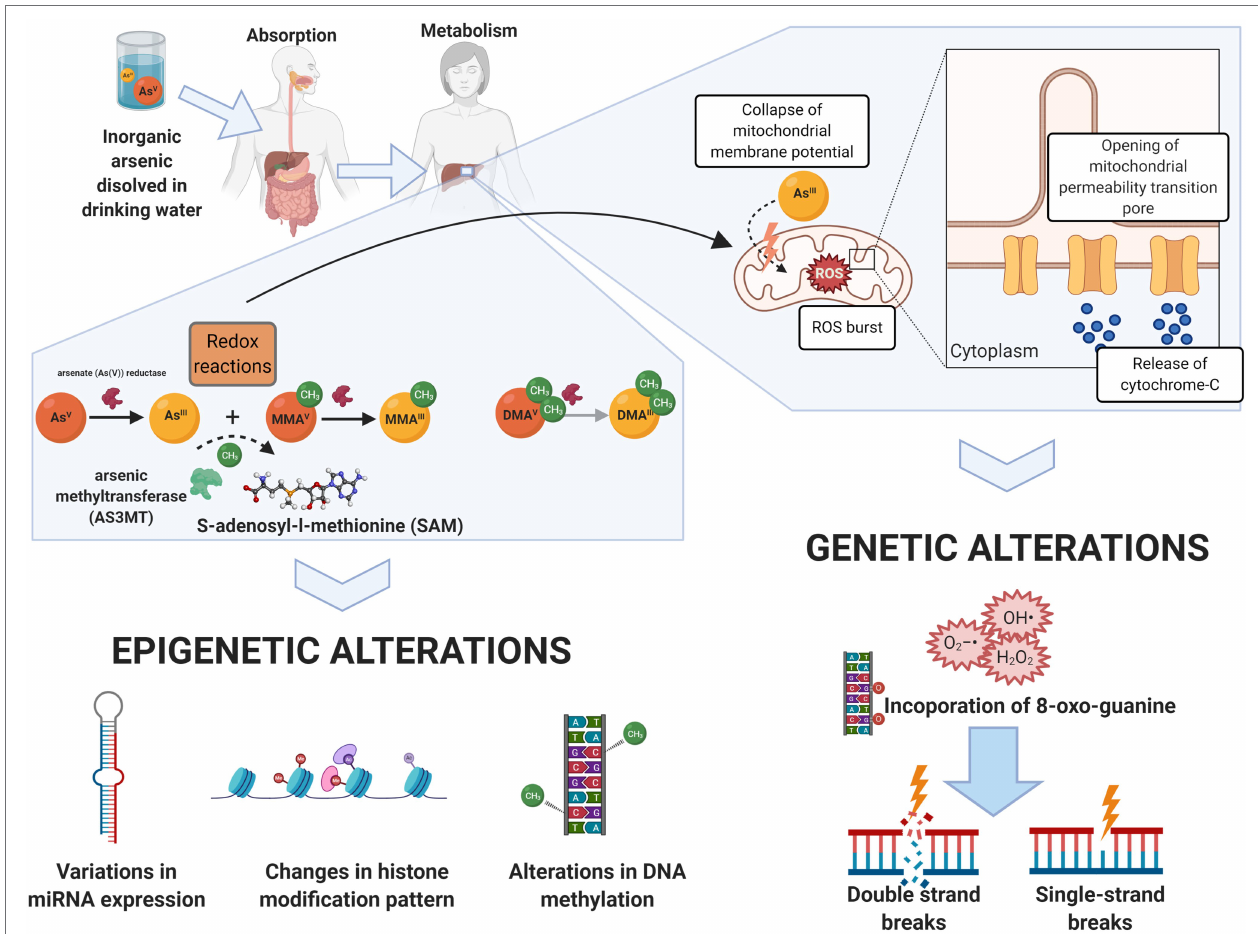
FIGURE 2 | Arsenic biotransformation as mechanisms for molecular damage. Arsenic dissolved in drinking water (mainly as arsenate, in its oxidation state +5, As[V]) is readily absorbed by the gastrointestinal tract. Biotransformation of arsenic occurs in the liver, where arsenite (As[III]) and As[V] goes through a series of redox reactions, resulting in the generation of mono and dimethylated arsenic intermediaries: Monomethylarsonous acid (MMA[III]), monomethylarsonic acid (MMA[V]), dimethylarsinous acid (DMA[III]), and dimethylarsinic acid (DMA[V]). S-adenosylmethionine (SAM) is the methyl donor during arsenic biotransformation to both oxidation state III and oxidation state V arsenic species. The transfer of a methyl group from SAM to trivalent arsenicals is catalyzed by the arsenic6 (+3 oxidation state) methyltransferase (AS3MT), producing methylated and dimethylated arsenicals. Epigenetic alterations, including global and local DNA methylation changes, alteration of miRNA expression, and changes in the histone modification pattern, are associated with this process. On the other hand, the redox reactions involved in arsenic biotransformation lead to ROS-mediated disruption of the mitochondrial electron transport chain, which subsequently results in DNA damage such as double- and single-strand breaks, and specific mutational patterns. Created with